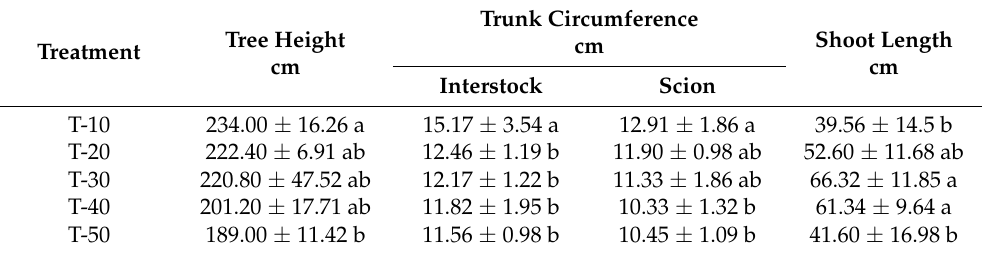
Table 1. Effects of dwarfing interstock length on apple tree growth